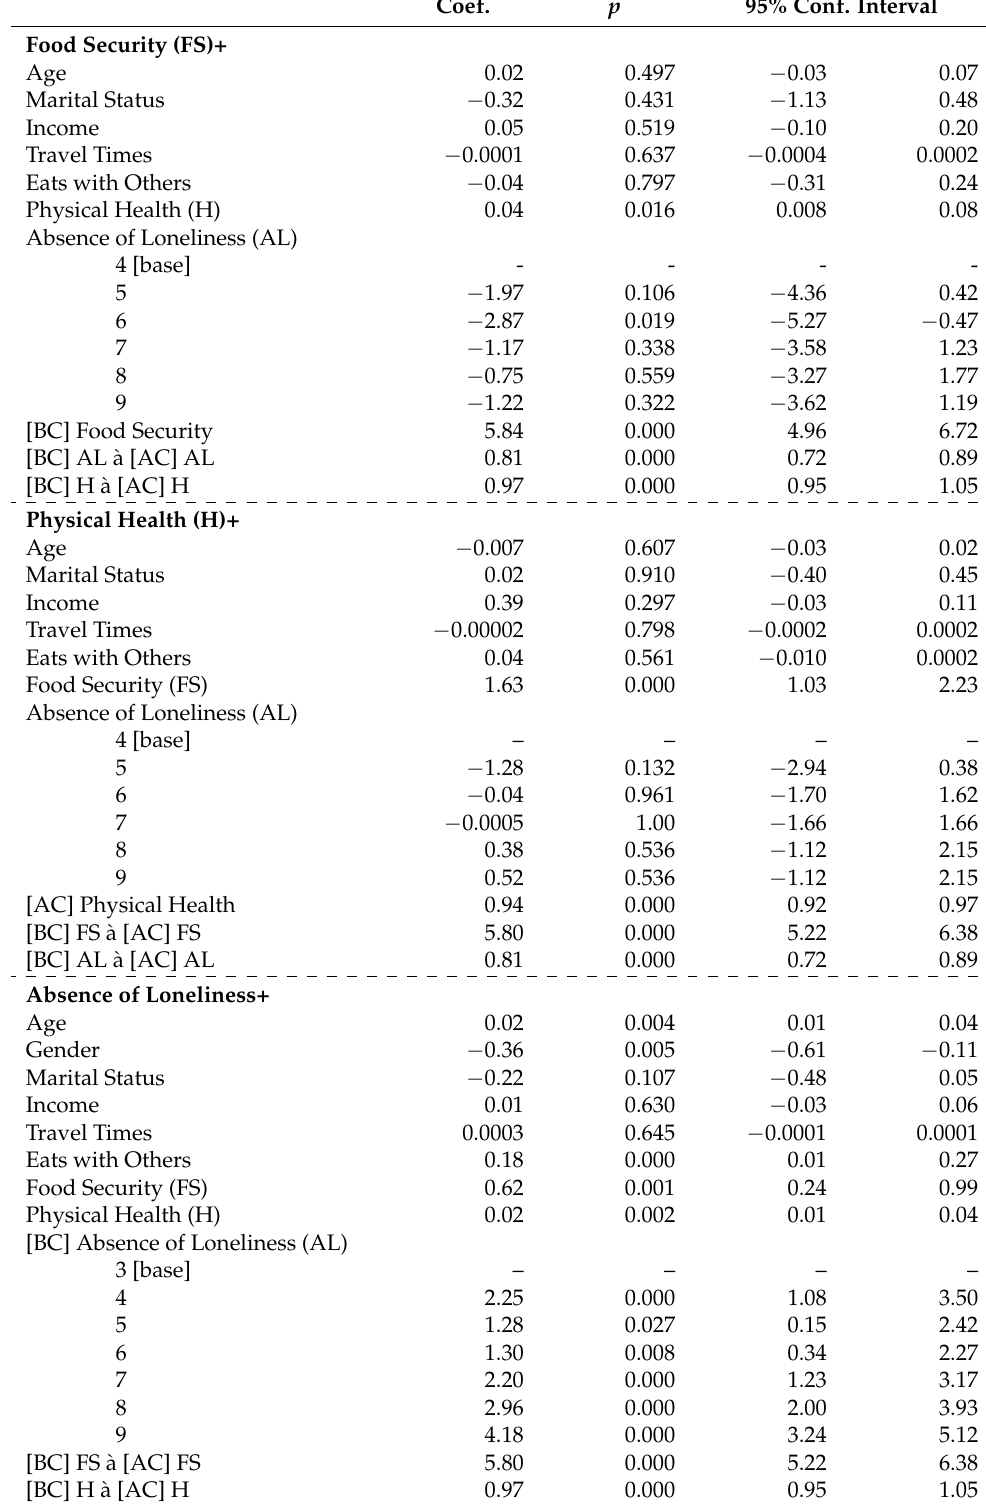
Table A3. The difference before and after COVID structural equation modeling